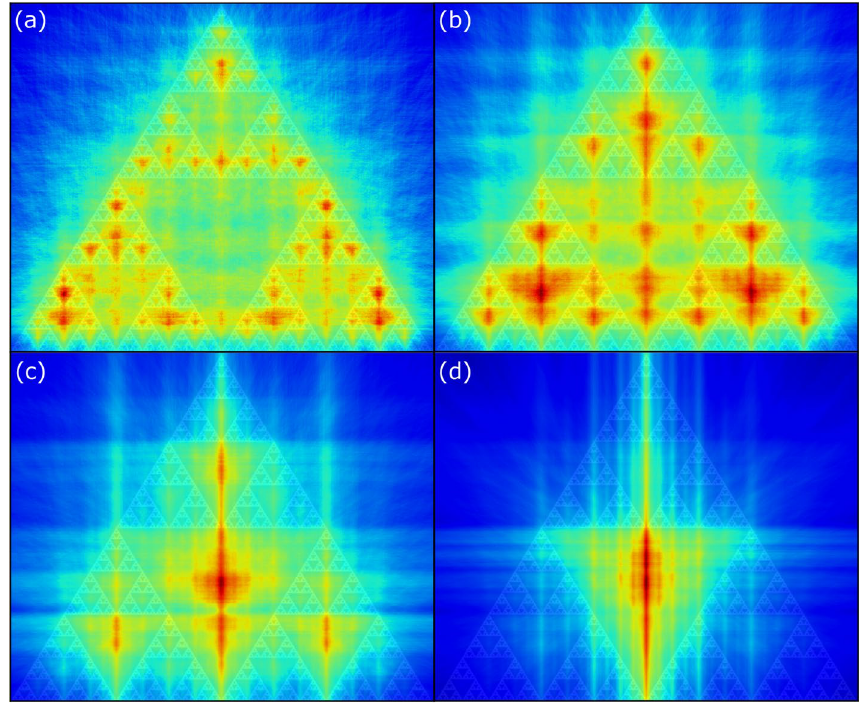
Figure 7. An iterated function system (IFS) fractal of triangles processed through the symmetry density algorithm with distance limits of ( a ) 9%, ( b ) 19%, ( c ) 39%, and ( d ) 78% of the image size, shows that by limiting the definition of coincidence to points of an a priori scale, features at the scale highlighted due to the contribution of equidistant point-pairs across lines of symmetry, while point-pairs off lines of symmetry contributing to noise are reduced.